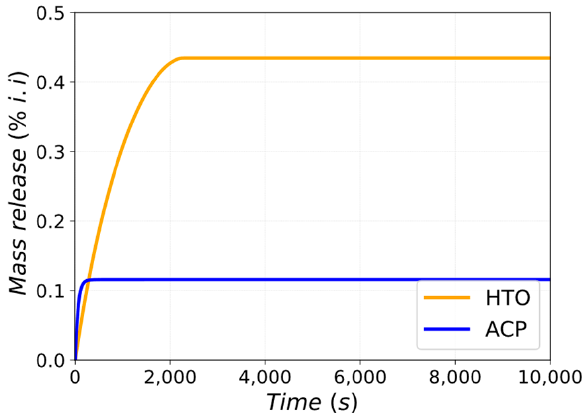
Figure 29. Direct unfiltered release of HTO and ACP (%i.i.).